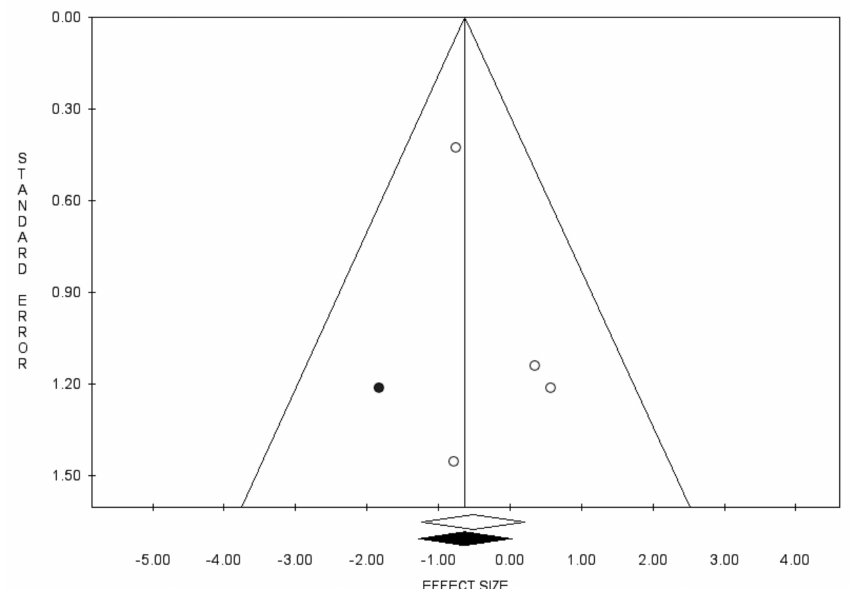
Figure 9. Funnel plots of the meta-analysis evaluating the association between use of 5-ARIS or ADT and the RR of BCa progression. Egger’s linear regression (t = 1.46, p = 0.282) and Begg and Mazumdar rank correlation test (z = 0.68, p =